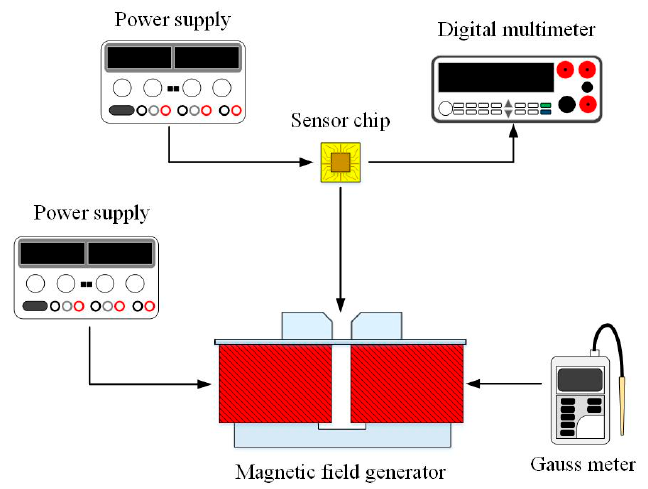
Figure 11. Measurement setup for the MS.